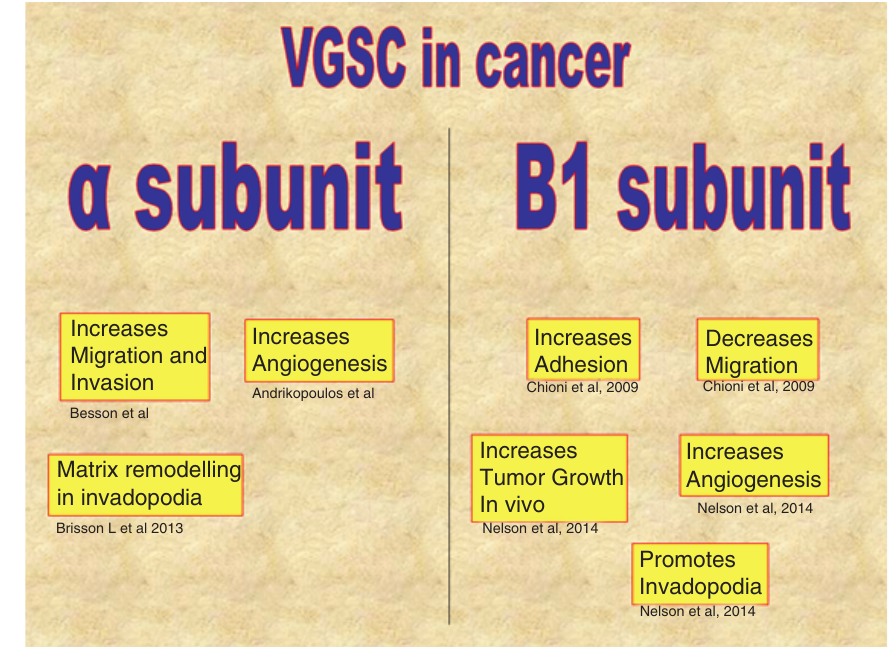
Figure 7. Activities of alpha and beta-1 subunits of VGSCs in cancer 131–133 .